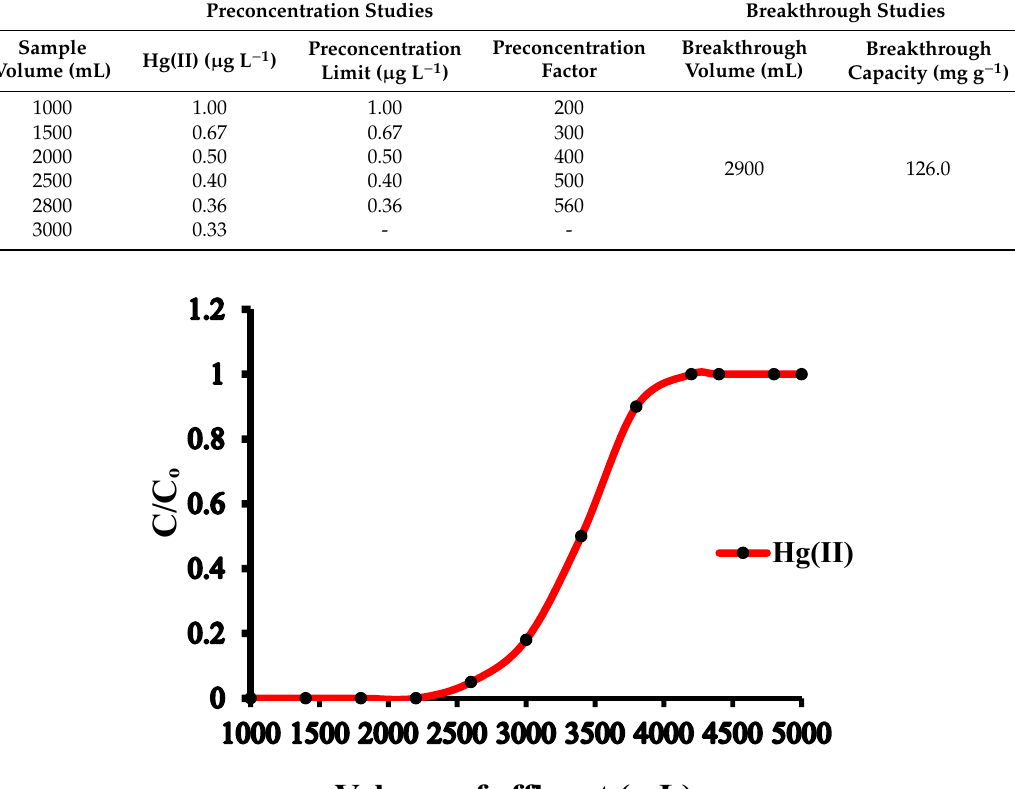
Figure 6. Breakthrough curve for the Hg(II) uptake.